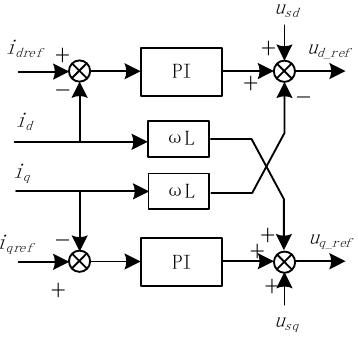
Figure 4. Inner loop control strategy of soft open point.